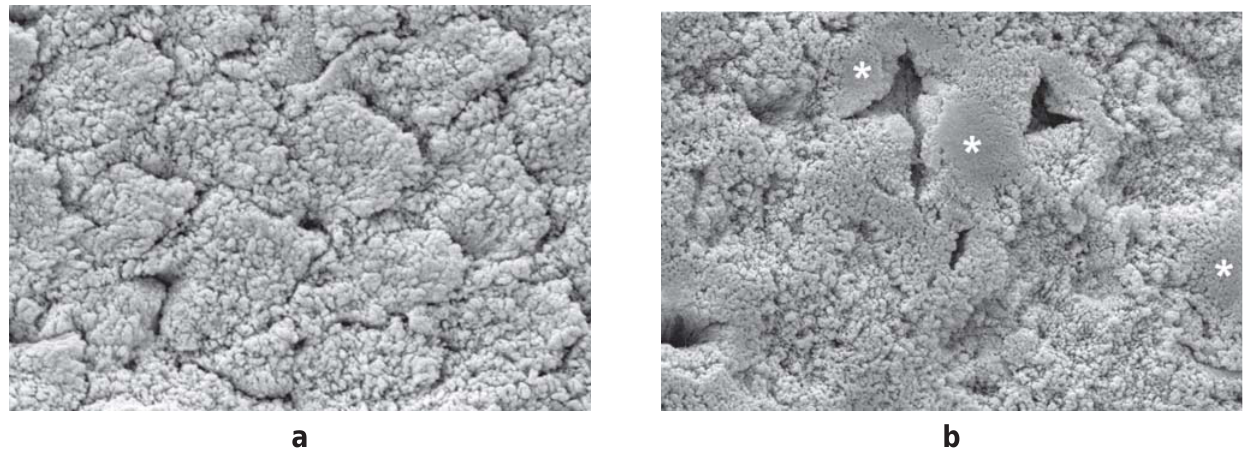
FIGURE 2- SEMs of ground (2a) and intact (2b) enamel surfaces etched with 35% phosphoric acid. Dissolution of prism core and boundaries can be observed (2a) and a non-uniform etching with aprismatic layer remnants (*) in intact surfaces (2b) (x10,000)